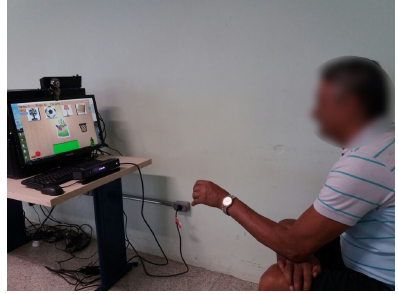
Figure 5: Experiment being conducted with a patient. The protocol was composed by two parts: a pre-test session and a session with pre-determined amount of rounds to collect